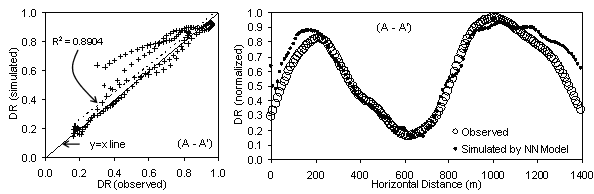
Fig. 10. The observed and simulated damage ratios for cross section A–A 0